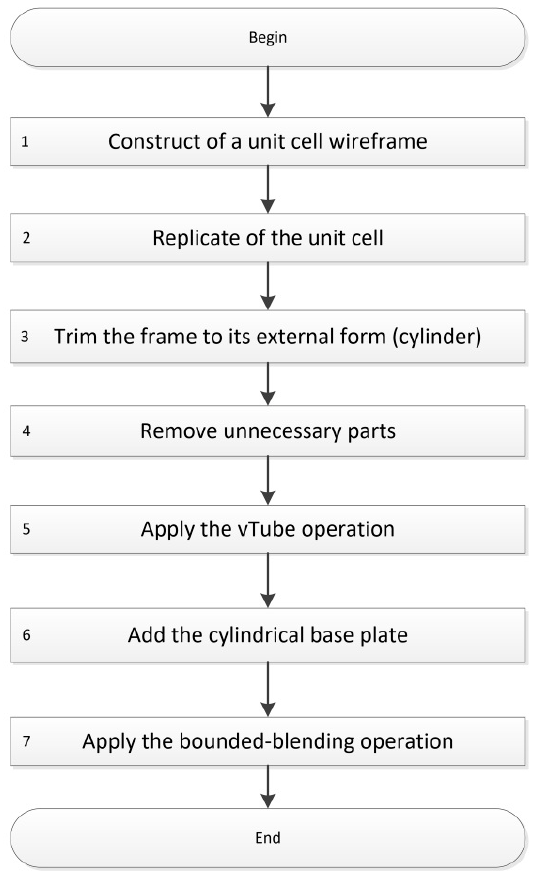
Figure 3. Workflow of the modeling process with Symvol FRep plugin for Rhino version 1.5.